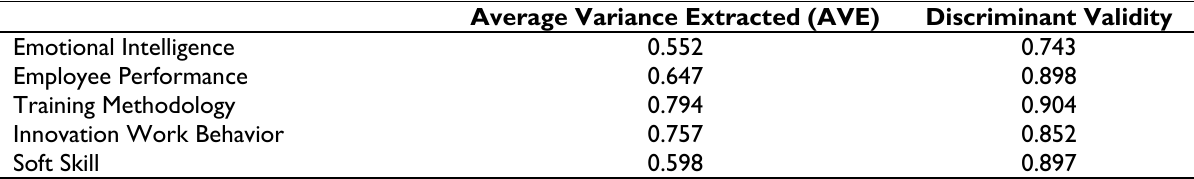
Table 1. AVE and Discriminant Validity